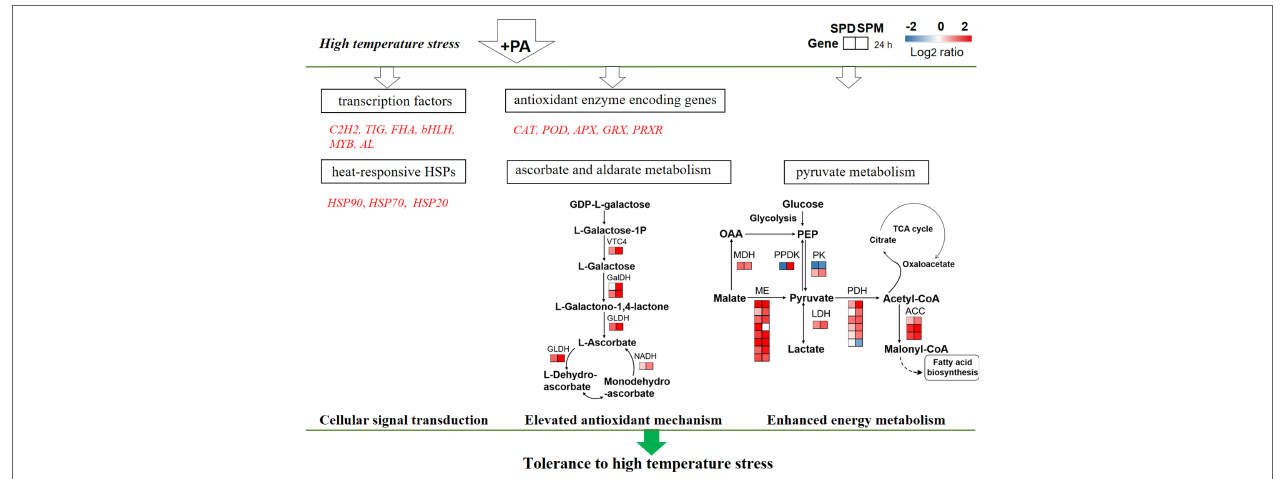
FIGURE 7 | PA-induced transcriptomic changes of DEGs and pathways under HT stress. For DEGs analysis, the red font indicates upregulated genes between the PA-treated and CK groups. Each square represents the log2 FC level of the corresponding DEG at 24 h, respectively. A red square indicates upregulation and a blue square indicates downregulation. The ratios of gene expression levels between the PA-treated and CK groups are listed in Supplementary Table S8 . Abbreviations: C2H2, cys2his2-type zinc-finger protein family; TIG, tetanus immune globulin family; FHA, fork head-associated domain (FHA domain) containing protein; bHLH, basic helix–loop–helix protein family; MYB, myeloblastosis family; AL, alfin-like transcription factor family; CAT, catalase; POD, peroxidase; APX, ascorbate peroxidase; GRX, glutaredoxin; PRXR, peroxiredoxins; HSP, heat shock